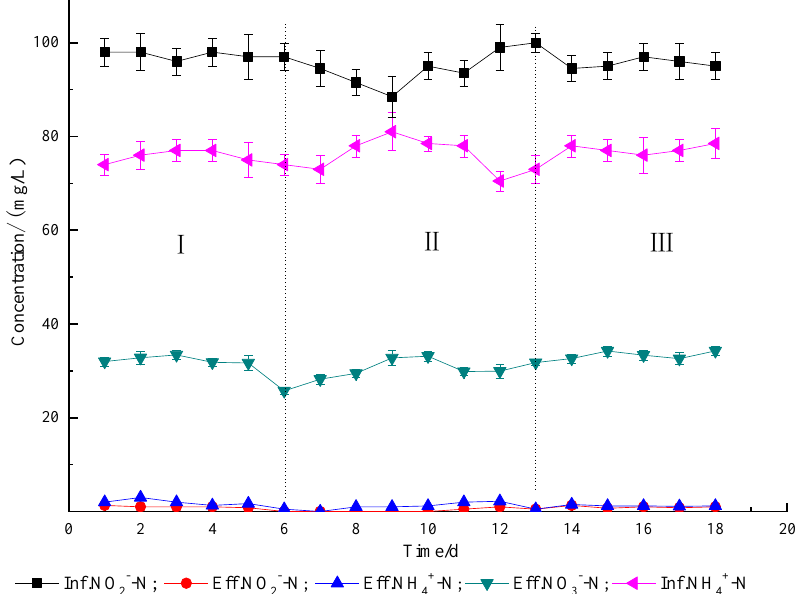
Figure 5. Nitrogen relationship between influent and effluent in anammox; Stages I, II, and III indicate that HRT is 33.4, 24, and 14.5 h, respectively.